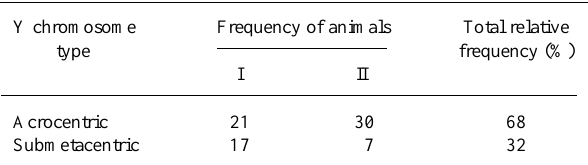
Table I - Polymorphism in the Y chromosome morphology of “pé-duro” bulls.